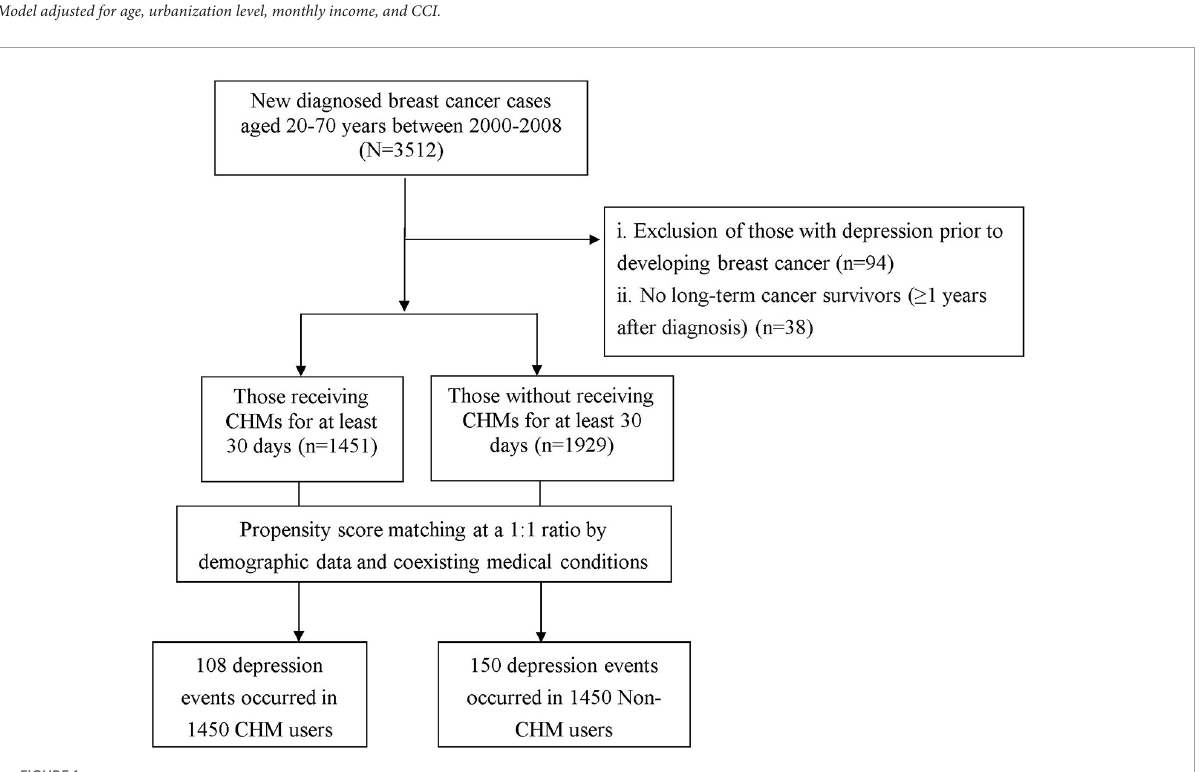
FIGURE1 Flow chart of selection and follow-up of study